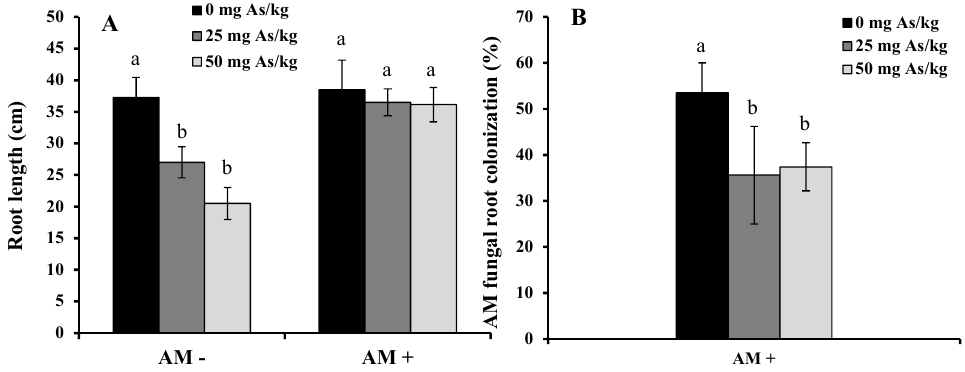
Figure 2. (A ) Soybean plant height; ( B ) number of soybean functional leaves. Letters indicate significant differences between treatments ( p < 0.05), as assessed by Tukey’s test.